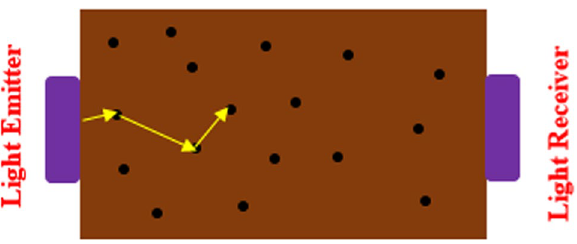
Fig. 26 Schematic of HPHT PVT cell equipped with NIR source and detector for light scattering technique (Jamaluddin et al. 2002)